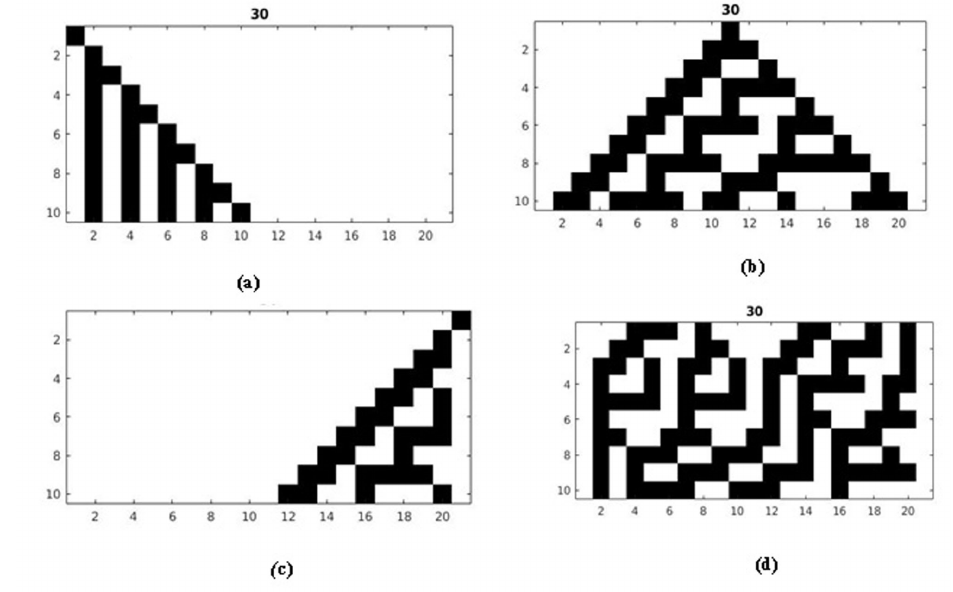
Figure 1: Example of Wolfram Rule 30. A one-dimensional random number generator: Wolfram CA rule 30. Grid size is N = 21. White squares represent cells in state 0, black squares represent cells in state 1. Initial representations are – a) [1 0 00 0 0 0 0 0 0 0 0 0 0 0 0 0 0 0 0 0], b), [0 0 0 0 0 0 0 0 0 0 1 0 0 0 0 0 0 0 0 0 0], c) [00 0 0 0 0 0 0 0 0 0 0 0 0 0 0 0 0 0 0 1] and d) [0 0 0 1